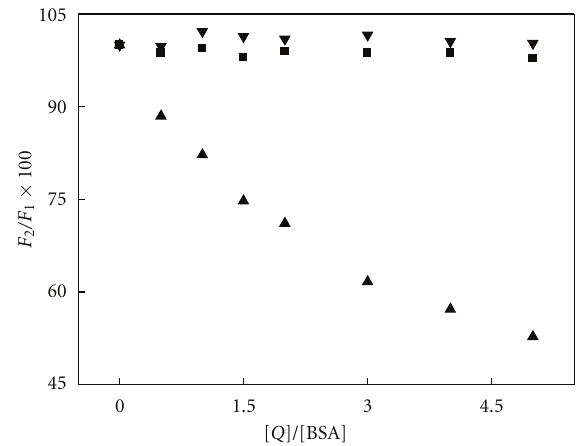
Figure 5: E ff ect of site maker probe on the fluorescence intensities of BSA-Avelox system C Avelox = C BSA = 1.0 × 10 − 6 M; C Q = (0.5, 1.0, 1.5, 2.0, 3.0, 4.0, 5.0) × 10 − 6 M. [ Q ]: (cid:2) WF; (cid:3) CP; (cid:4) DG; λ ex = 280nm; T = 293 K.